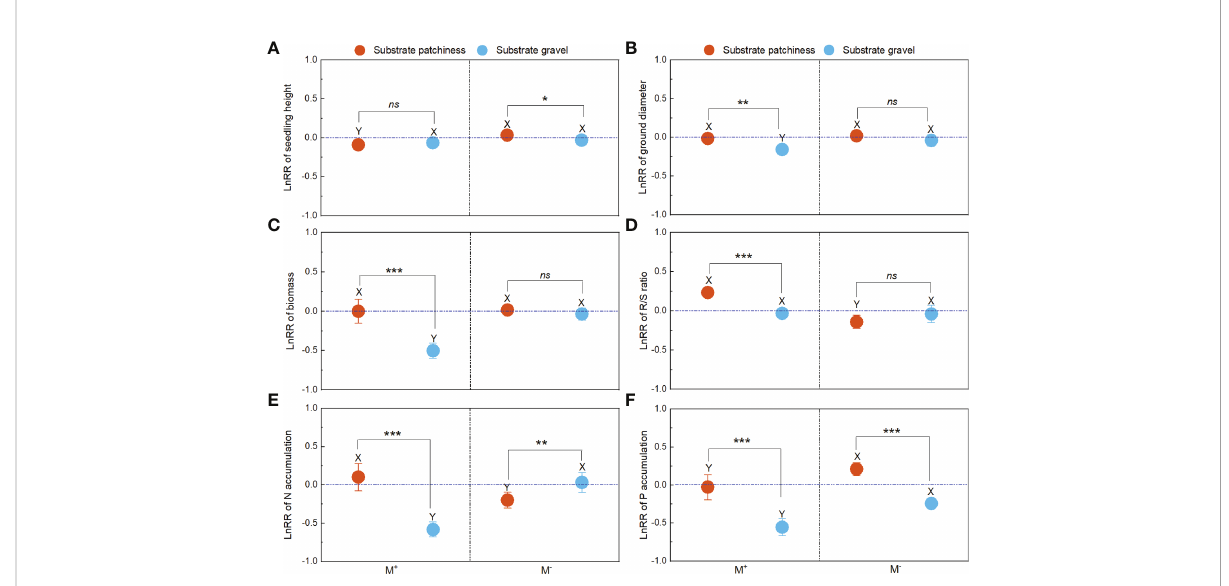
FIGURE 5 The LnRR of plant growth and nutrition across substrate patchiness and substrate gravel. For LnRR of the seedling height (A) , ground diameter (B) , biomass (C) , R/S ratio (D) , N accumulation (E) , and P accumulation (F) , M + and M – are the same as in Figure 2. The different capital letters (X, Y) indicate signi fi cant differences between M + and M - treatments; the * indicate signi fi cant differences between substrate patchiness treatments and substrate gravel treatments (* indicate P < 0.05; ** indicate P < 0.01; *** indicate P < 0.001) and the ns indicates non-signi fi cant differences between substrate patchiness treatments and substrate gravel